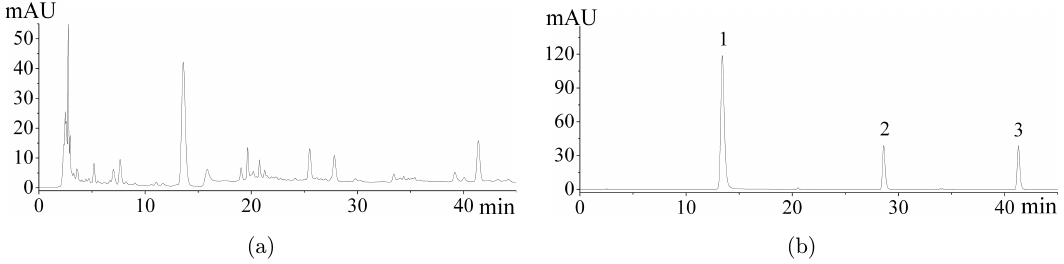
Fig. 1. Typical HPLC chromatograms of an extraction solution (a) and the mixed standard solution (b) (1. Puerarin, 2. salvianolic acid B, 3.